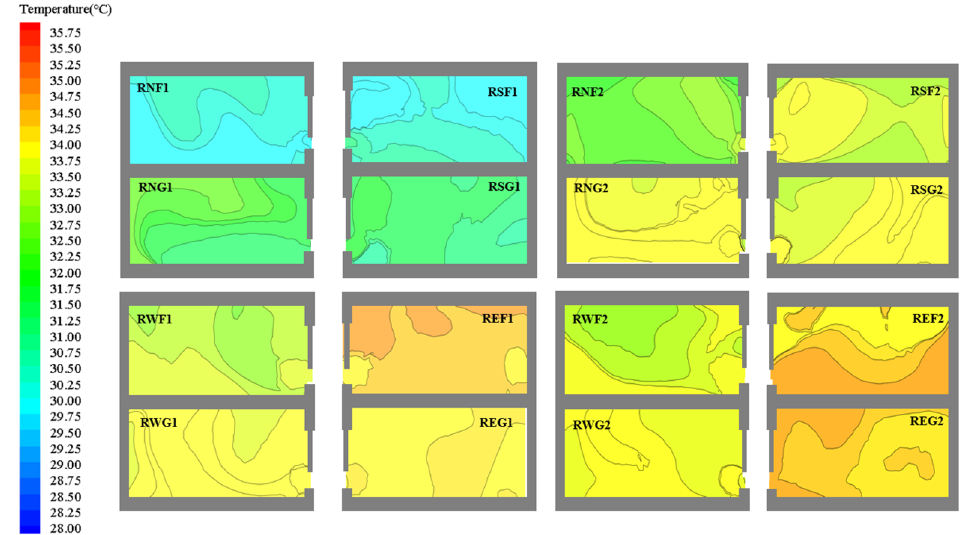
Figure 18. Simulated results of the air temperature contour with isotherm in each room for the baseline courtyard model with four small trees.